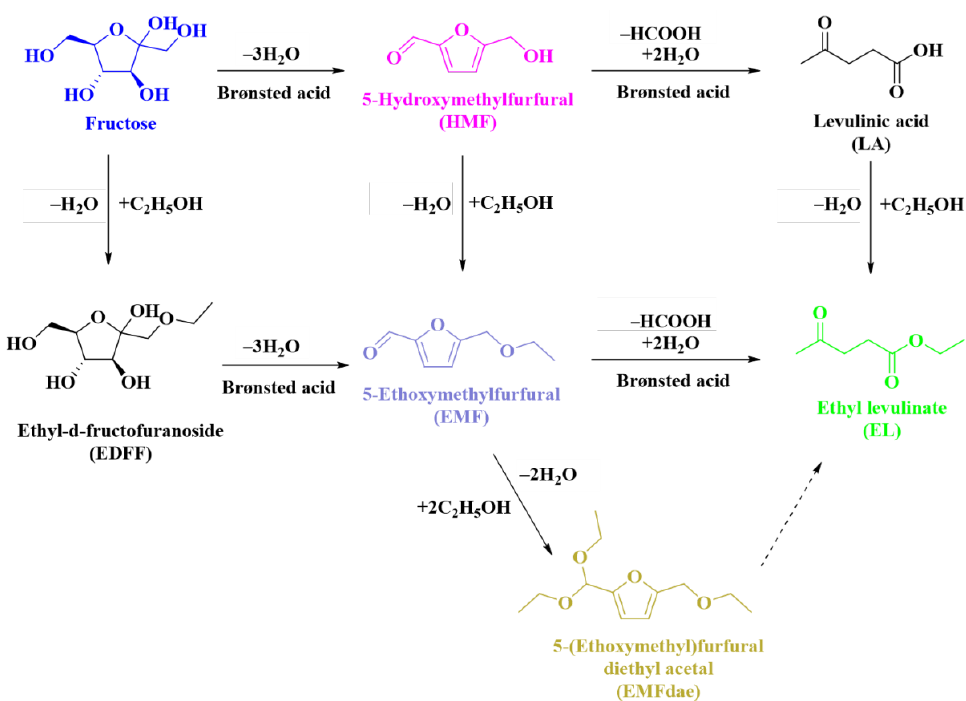
Scheme 1. Schematic pathway of EL formation from